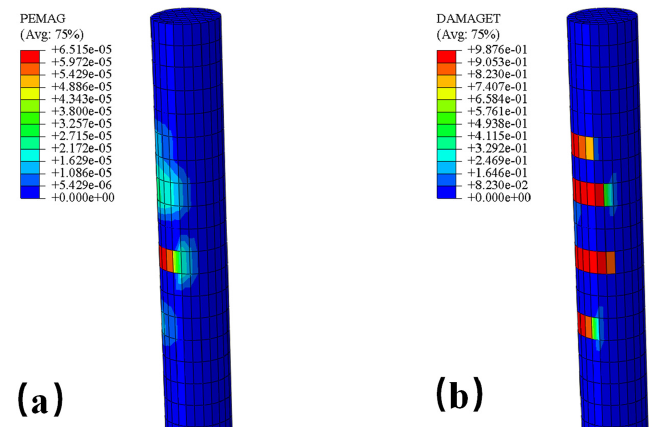
Figure 11. Distribution of ( a ) plastic strain, and ( b ) concrete tension damage at the upper part of the pile body under 814 kN horizontal load.